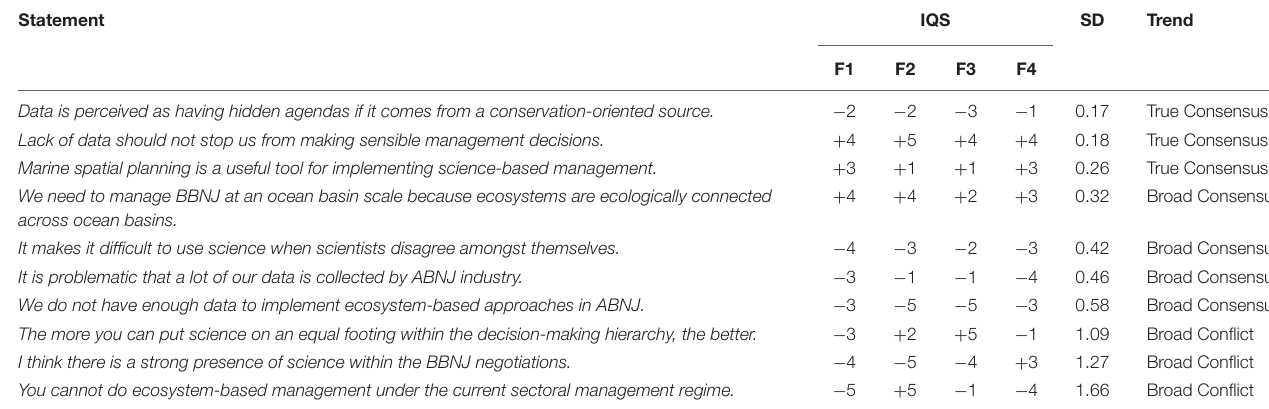
TABLE 3 | Identified consensus and conflict statements: Statements sorted by standard deviation (variance across factor z -scores for each statement), with corresponding idealised Q-sort scores (IQS) for each factor ( F ) and category of consensus or conflict (Trend). Statement